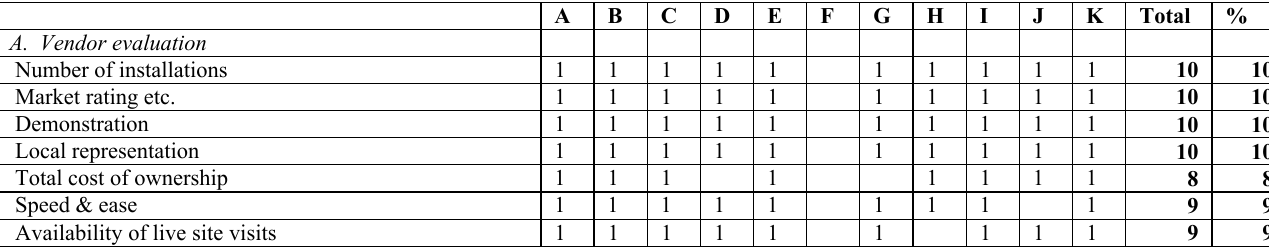
Table 3: Summary of vendor selection criteria considered 1